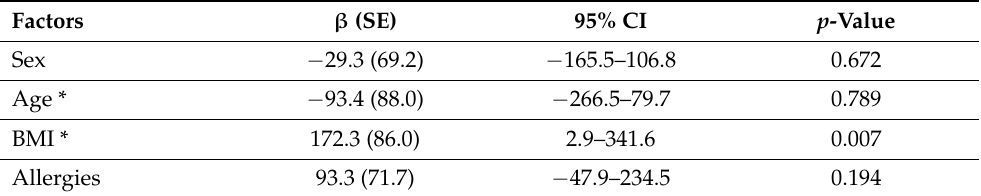
Table 3. Multivariable analysis of the association between anti-SARS-CoV-2 titers and sample characteristics (all participants).